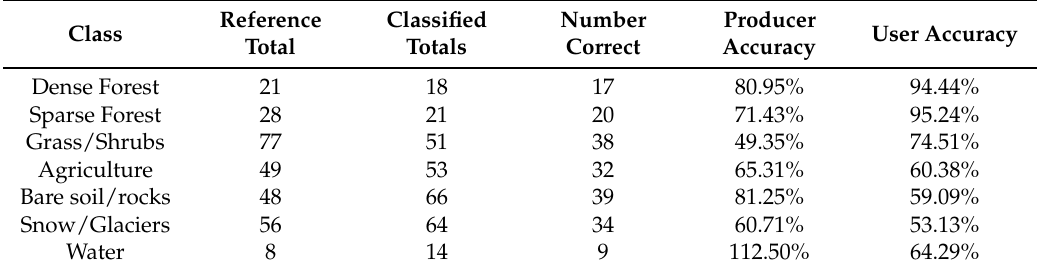
Table 5. Summary of the gridded systematic assessment results.